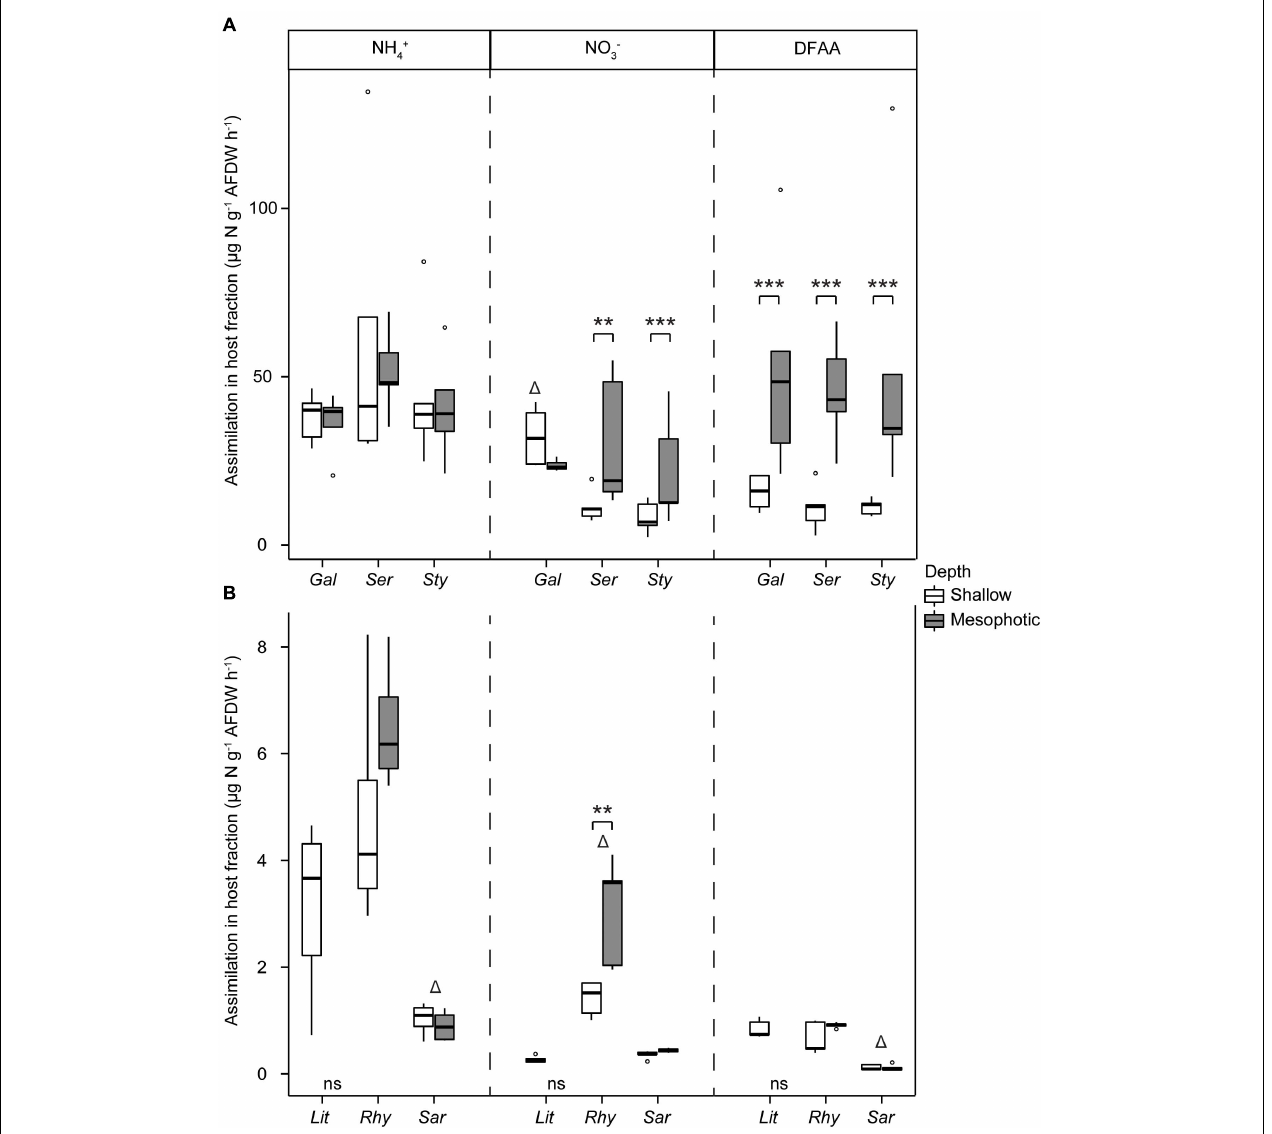
FIGURE 6 | Assimilation rates of dissolved N in the host tissue in (A) hard corals [ Galaxea fascicularis (Gal), Seriatopora hystrix (Ser), Stylophora pistillata (Sty)] and (B) soft corals [ Litophyton arboreum (Lit), Rhytisma fulvum fulvum (Rhy), Sarcophyton sp. (Sar)]. Significant differences between depths are displayed with asterisks (** for p < 0.01; *** for p < 0.001). (cid:49) shows the species that differentiates from the other two within its group (i.e., either hard or soft corals, for a single N source). AFDW = ash-free dry weight. DFAA = dissolved free amino acids. ns = not